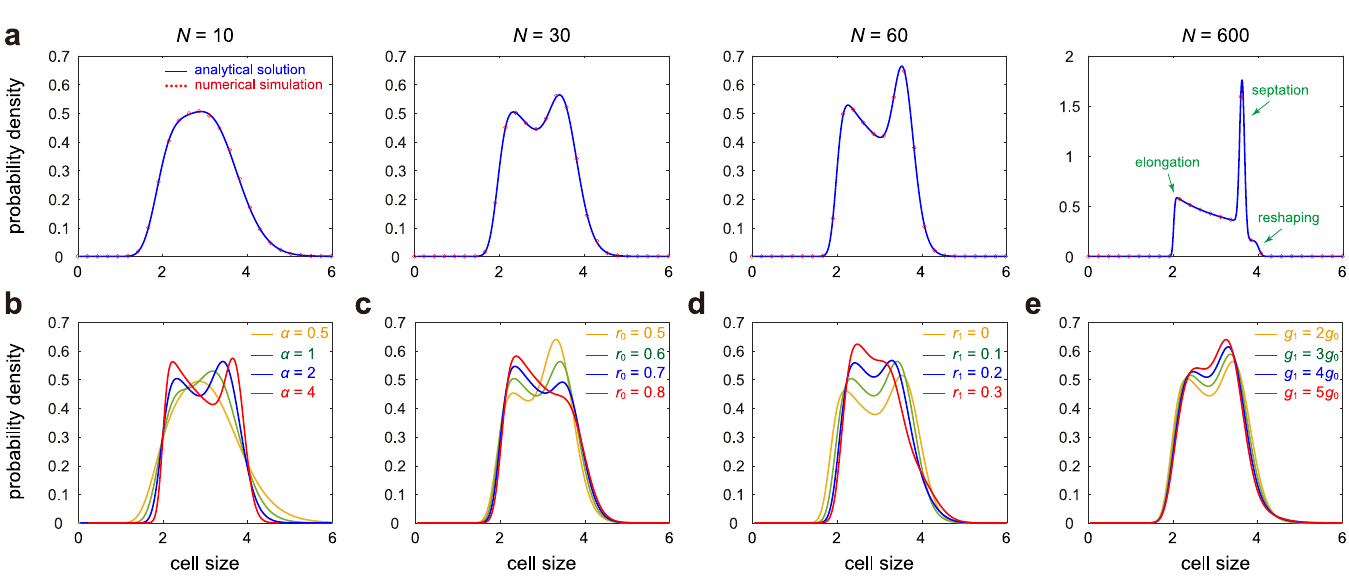
Fig 3. Influence of model parameters on the cell size distribution. A : Cell size distribution as N varies. The blue curve shows the analytical distribution obtained by taking the inverse Laplace transform of Eq (5) (e.g. using the technique described by Eqs (7) and (8)) and the red circles show the distribution obtained from stochastic simulations. The parameters are chosen as r 0 = 0.6, r 1 = 0.1, g 1 = 2 g 0 , α = 2. B : Cell size distribution as α varies. The parameters are chosen as N = 30, r 0 = 0.6, r 1 = 0.1, g 1 = 2 g 0 . C : Cell size distribution as r 0 varies. The parameters are chosen as N = 30, r 1 = 0.1, g 1 = 2 g 0 , α = 2. D : Cell size distribution as r 1 varies. The parameters are chosen as N = 30, r 0 = 0.6, g 1 = 2 g 0 , α = 2. E : Cell size distribution as g 1 / g 0 varies. The parameters are chosen as N = 30, r 0 = 0.6, r 1 = 0.1, α = 2. In A-E, the parameters g 0 and p are chosen as g 0 = 0.01, p = 0.5 and the parameters a , M 0 , M 1 are chosen so that the mean cell size h V i = 3.